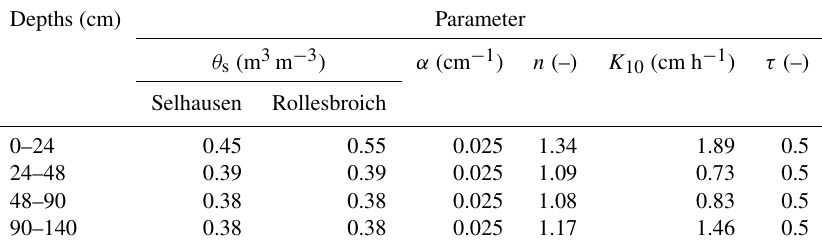
Table 3. Soil hydraulic parameters used in the modelling. Depths